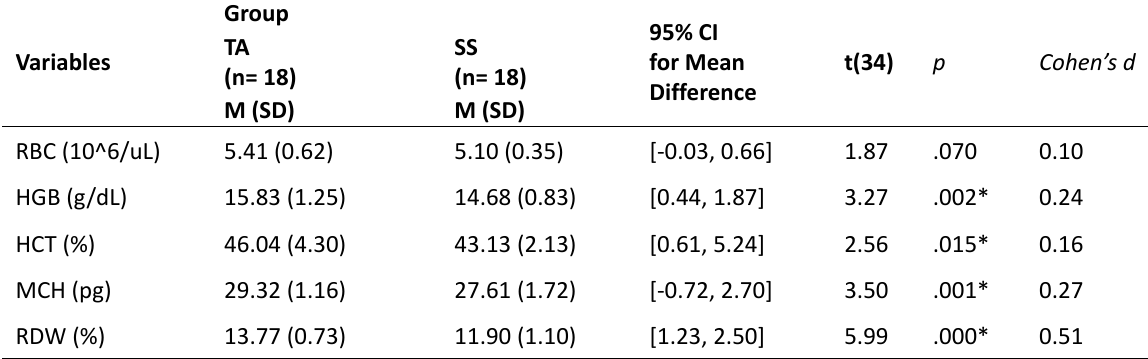
Table 1. Comparison of RBC parameters for TA and SS